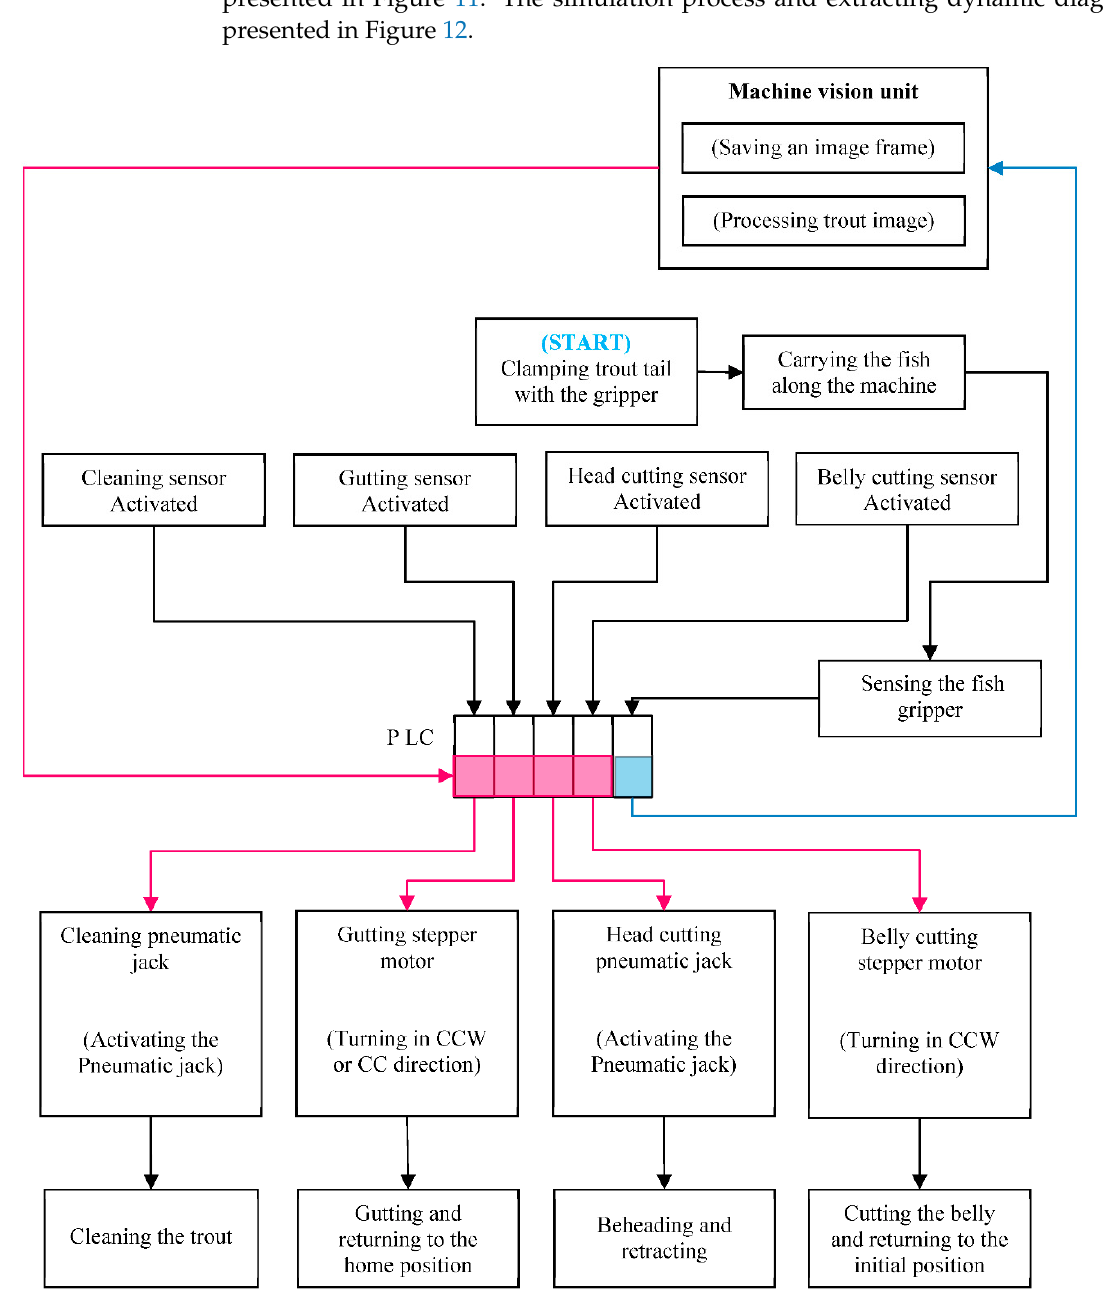
Figure 10. Function analysis of the trout fish-processing system.